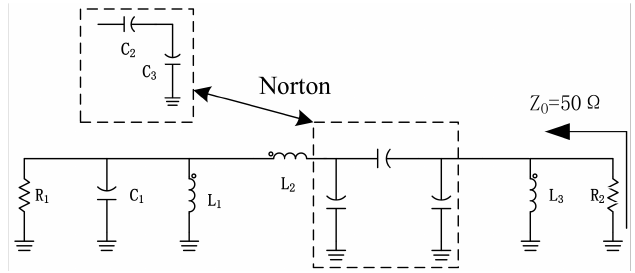
Figure 5. The topology of matching